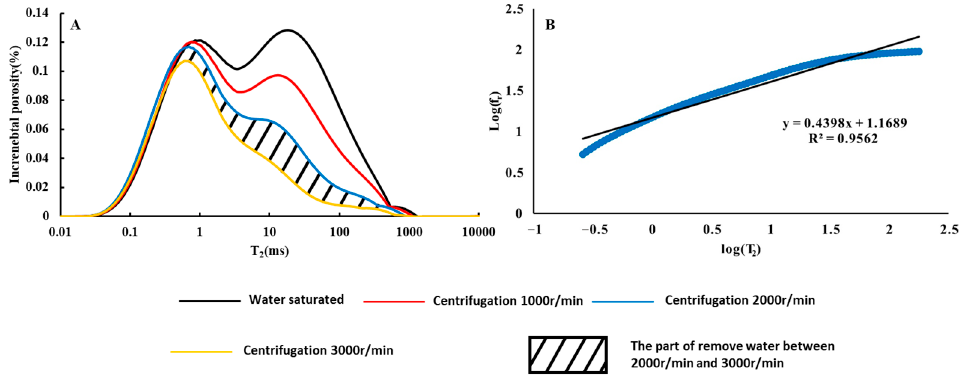
Figure 11. Trends of D s in different centrifugal speeds.